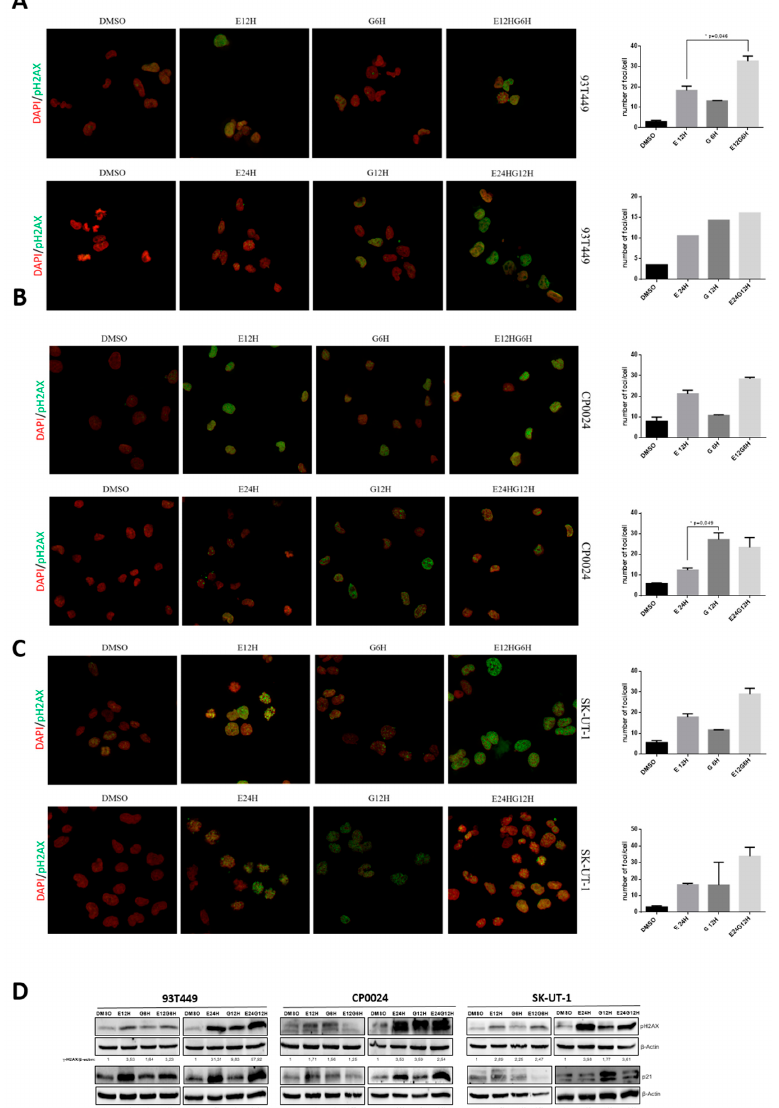
Figure 3. Study of DNA damage after combination of eribulin and gemcitabine in the 93T449, CP0024, and SK-UT-1 cell lines. ( A ) Immunofluorescence of γ -H2AX foci after 24 or 12 h treatment with eribulin (10 nM) and/or 12 or 6 h with gemcitabine (30 nM) in 93T449 cell line. Cells were stained with DAPI dye (nuclear control, red) and antibody against γ -H2AX (green) and quantifica- tion of the number of foci per cell. ( B ) Immunofluorescence of γ -H2AX foci after 24 or 12 h treatment